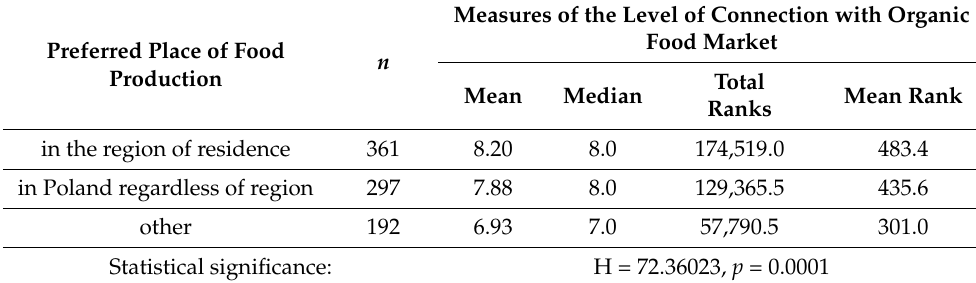
Table 4. Level of relationship of consumers with organic food